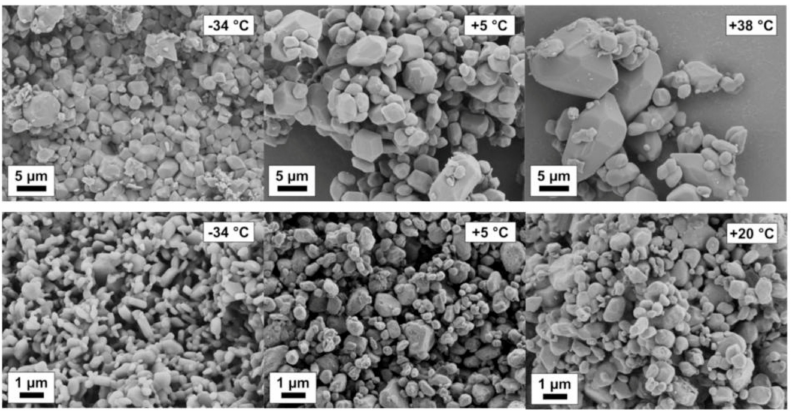
Figure 12. Naproxen particle ripening at varying temperatures in ethanol ( upper row ) and dichloromethane ( lower row